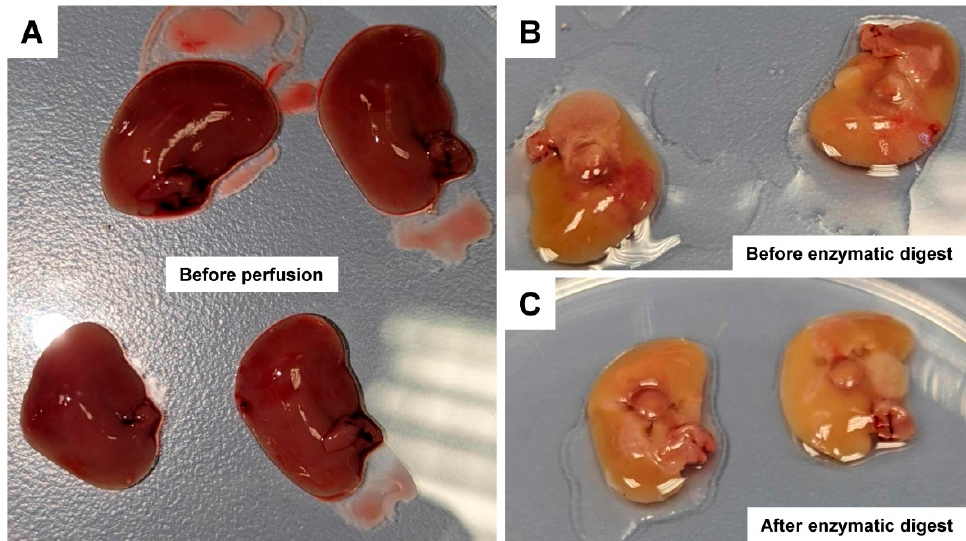
Figure 3. Color changes of the liver tissue during perfusion with the gentleMACS Perfusion Technology. ( A ) Four different liver lobes before perfusion are depicted. ( B ) The upper two liver lobes from ( A ) after perfusion with the pre-digestion buffer. ( C ) The lower two liver lobes from ( A ) after enzymatic digestion.